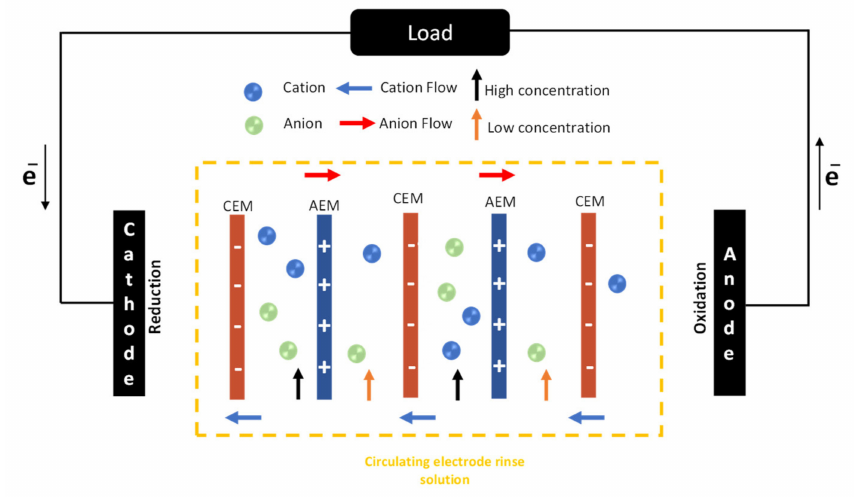
Figure 1. Schematic representation of the Reverse Electrodialysis RED (process). CEM: Cation exchange membrane; AEM: Anion exchange